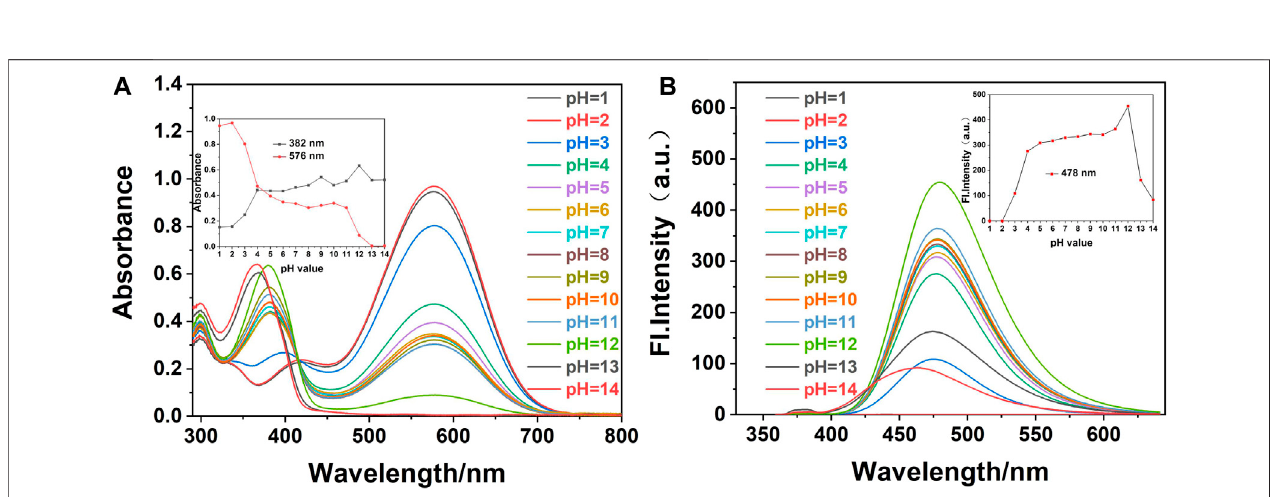
FIGURE 3 | (A) UV-Vis and (B) fl uorescence spectra of fl uorescence probe W (20 μ M) in EtOH/water (VEtOH/VH2O = 3/2) with the addition of CN − (40 μ M) at differentpHvalues( λ ex/ λ em=378 nm/478 nm,slit:5/5 nm,andvoltage:500 v).Inset: (A) effectofdifferentpHvaluesontheabsorbanceofprobeWwiththeadditionof CN − at 382 and 576 nm. (B) In fl uence of pH values on fl uorescence probe W with the addition of CN − at 478 nm.